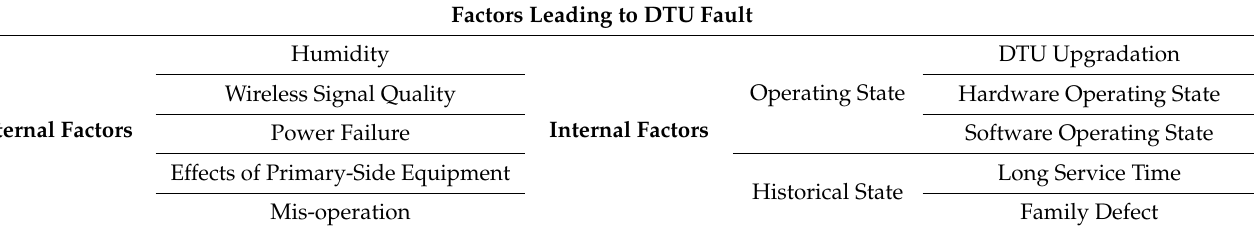
Table 2. Factors leading to DTU fault.